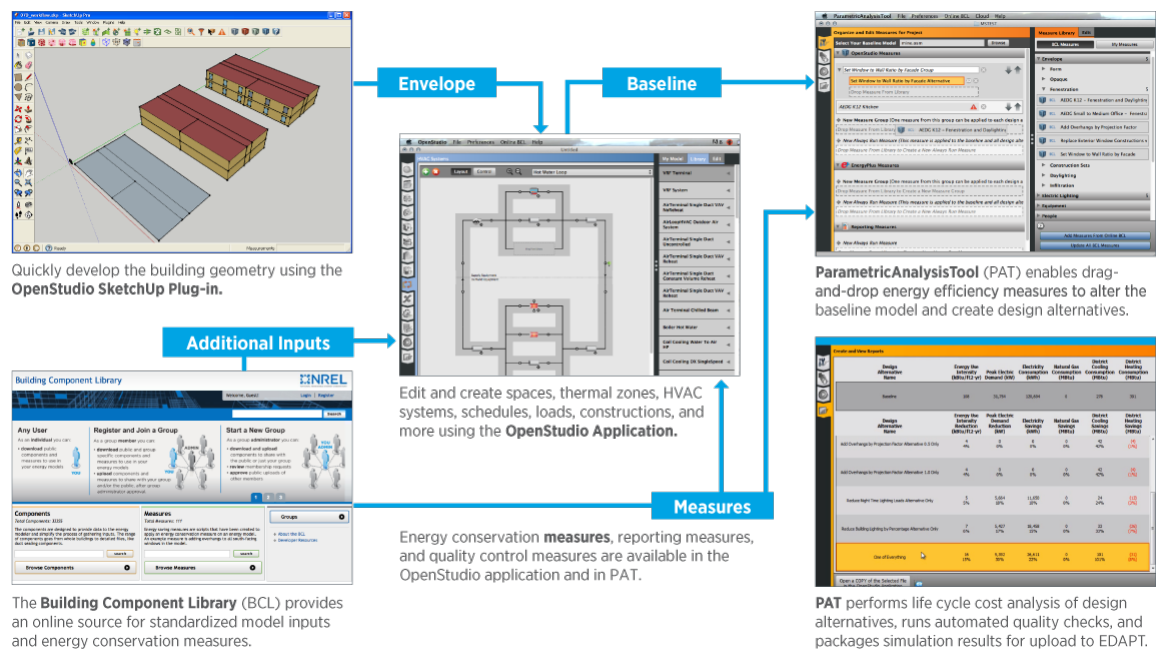
Figure 2. OpenStudio Application work flow, displays how a sketchup model can be loaded in and configured prior to running a EnergyPlus